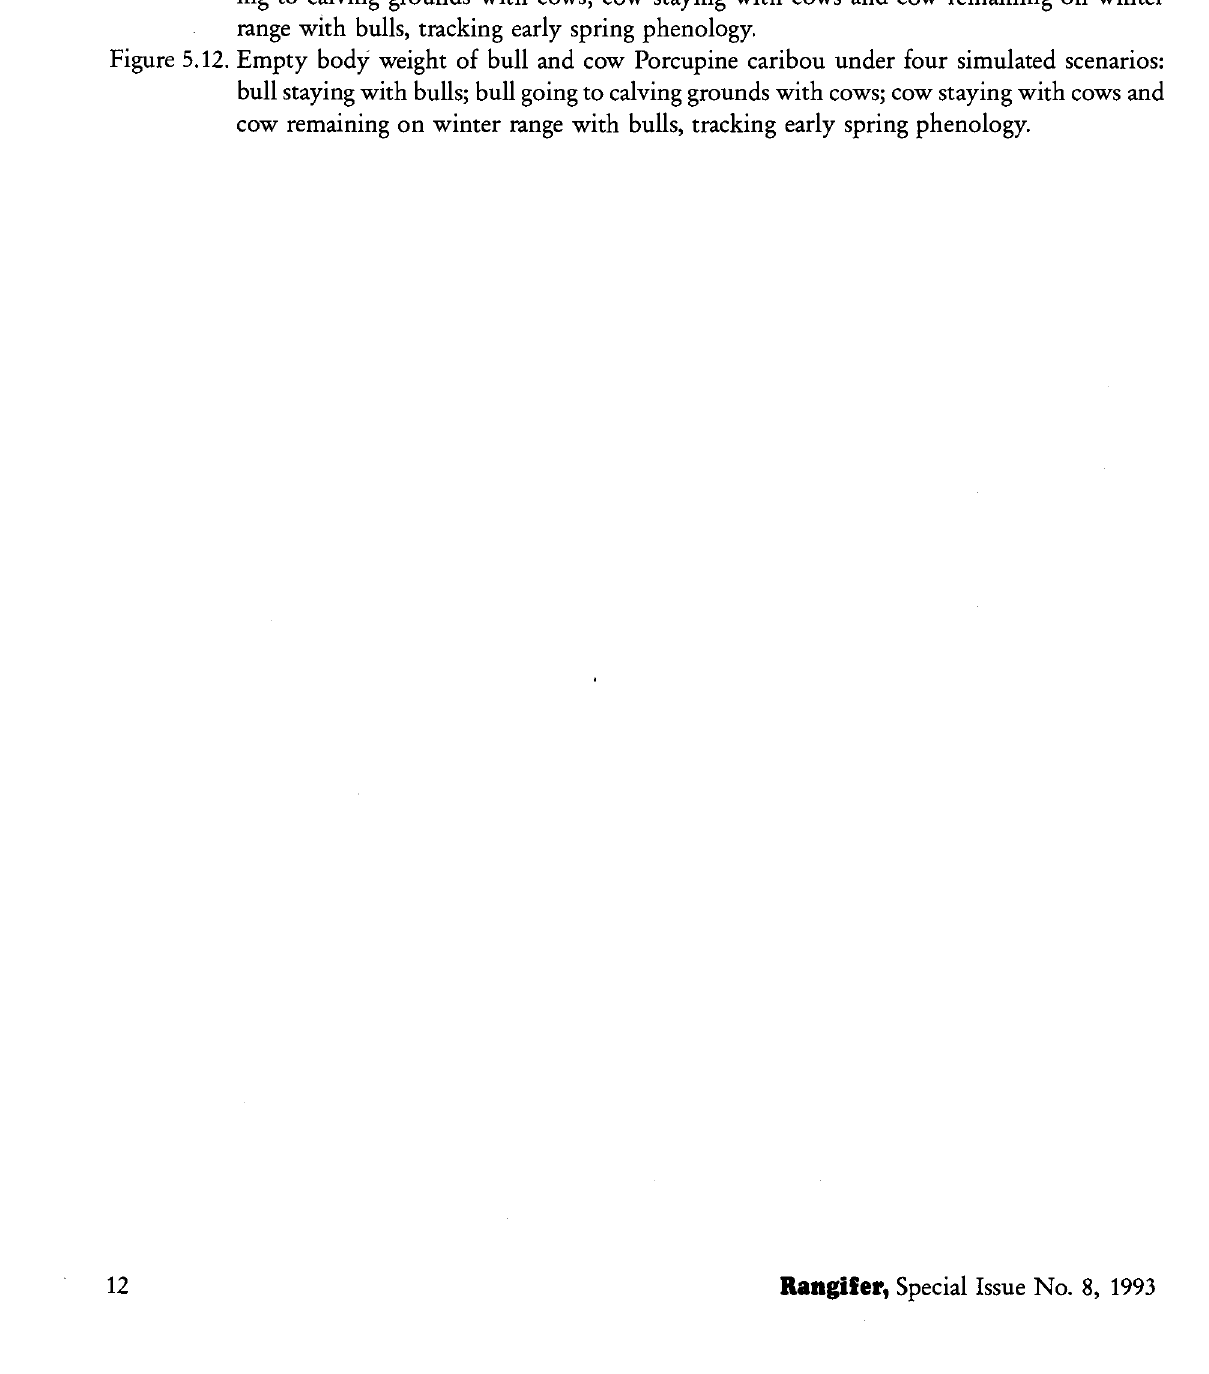
Figure 5.6. Energy balance - «good year* versus «bad» year for an adult cow of the Porcupine Cari bou Herd. Figure 5.7. Seasonal digestibility of the diets of an adult cow and bull of the Porcupine Caribou Herd. Figure 5.8. Weight of body fat reserves of a female Porcupine caribou in a «good» year versus «bad» year. Figure 5.9. Average daily (A) and total (B) seasonal fat change for an adult female Porcupine caribou. Figure 5.10. Total energy requirements for a bull and cow from the Porcupine Caribou Herd, from spring to the movement period. Figure 5.11. Cumulative energy balance for four simulated scenarios: bull staying with bulls; bull go ing to calving grounds with cows; cow staying with cows and cow remaining on winter range with bulls, tracking early spring phenology. Figure 5.12. Empty body weight of bull and cow Porcupine caribou under four simulated scenarios: bull staying with bulls; bull going to calving grounds with cows; cow staying with cows and cow remaining on winter range with bulls, tracking early spring